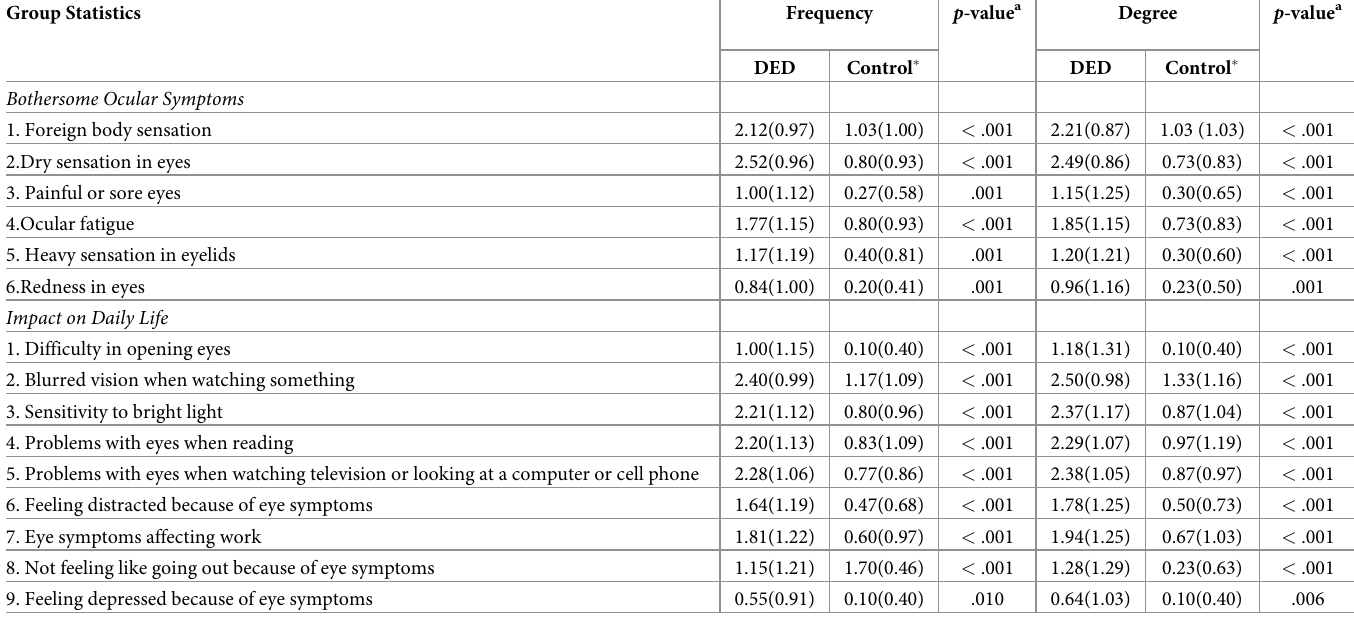
Table 3. Mean score of each item of the DEQS-Th between DED and non-DED participants.